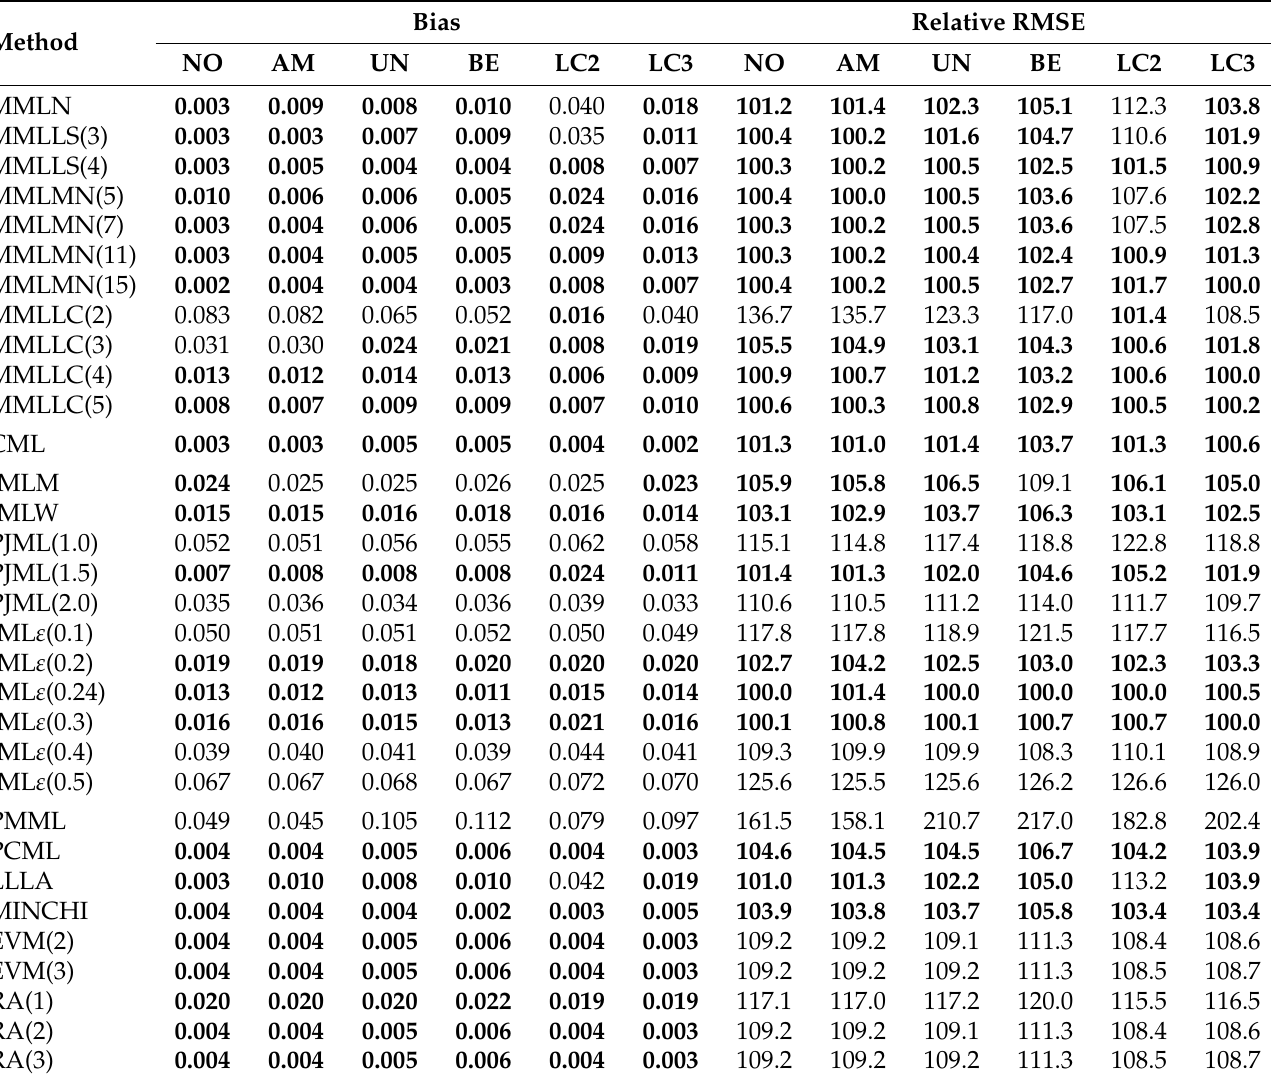
Table A3. Bias and relative RMSE for different estimation methods for a sample size of N = 1000 and I = 30 items for a test with a wide range of symmetrically distributed item difficulties as a function of the data-generating trait